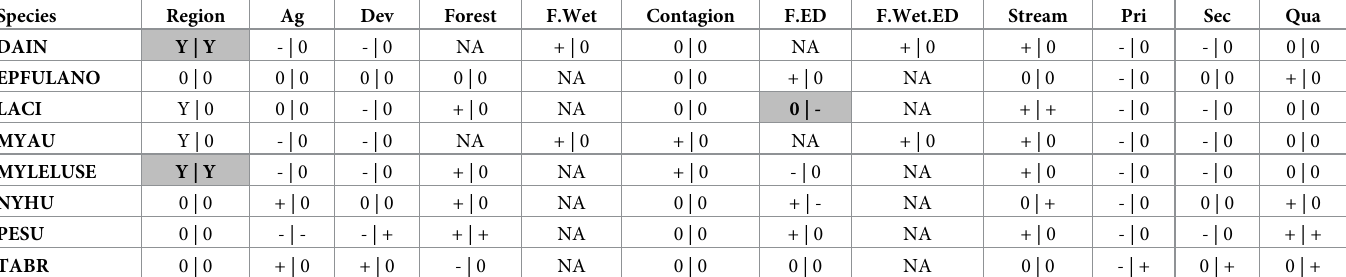
Table 1. Predicted and observed effects of environmental variables on the probability of occupancy for each species surveyed in South Carolina, May-July 2015 and 2016.